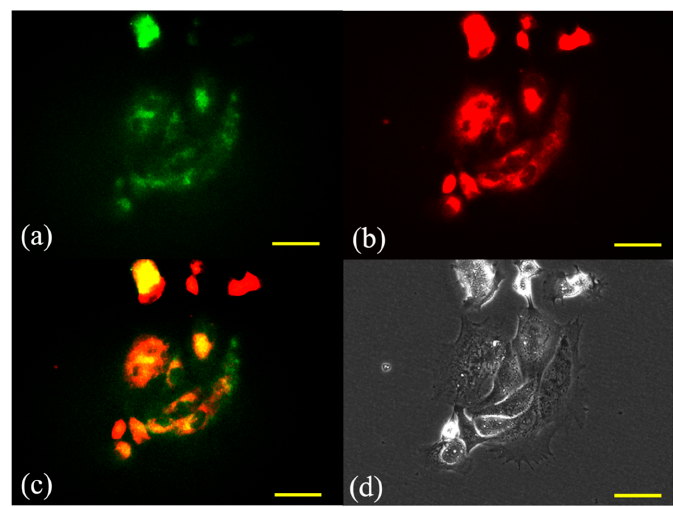
Figure 3. Subcellular localization of glucose-conjugated chlorin e6 in the lysosome after 6 h of incubation. The subcellular localization of glucose-conjugated chlorin e6 (G-Ce6) was characterized using fluorescence microscopy. ( a ) Green fluorescence of LysoTracker Yellow HCK-123 stained lysosome, ( b ) red fluorescence of G-Ce6 in the same view as ( a ), ( c ) combination of ( a ) and ( b ) images, and ( d ) transmission images. The images showed that G-Ce6 mainly localized in the lysosomes. Scale bar, 50 µ m.